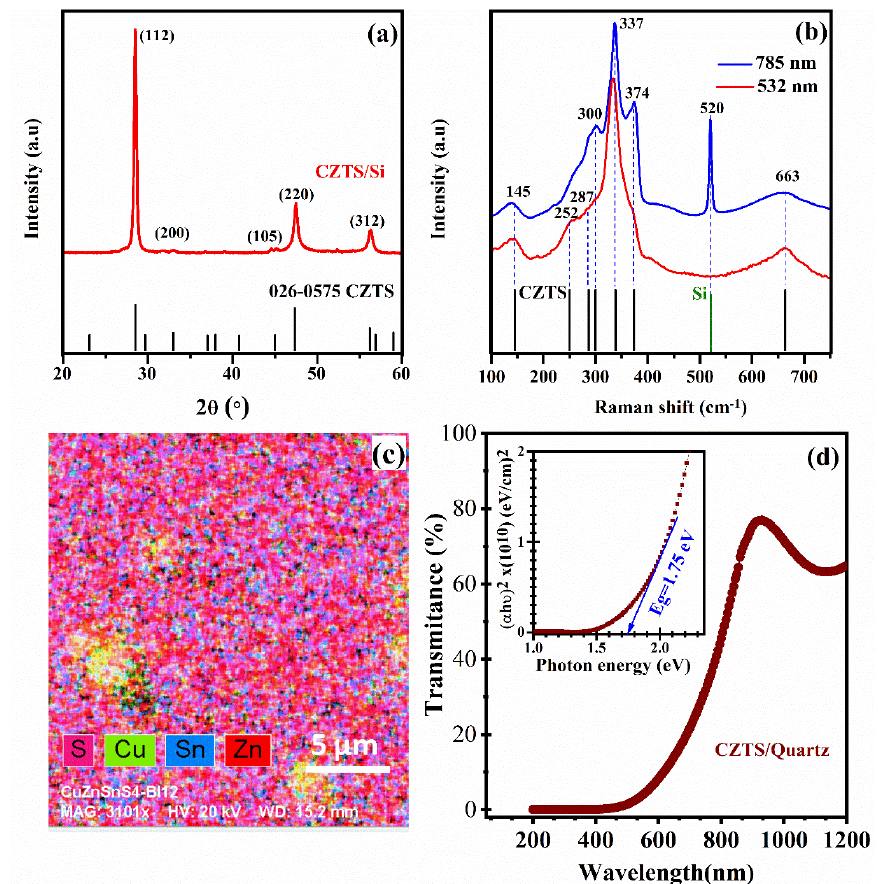
Figure 1. ( a ) Typical XRD pattern of a PLD-CZTS film deposited at N LP = 15000 onto Si (100) substrates (the underlying tick marks indicate the XRD peak positions of the kësterite crystalline structure according to the JCPDS (26-0575) file); ( b ) Raman spectra of the same PLD-CZTS film at two excitation wavelengths (532 and 785 nm); ( c ) EDX mapping of the S, Cu, Sn and Zn elements forming the PLD-CZTS film; ( d ) UV-Vis Transmittance spectrum of the same PLD-CZTS film deposited on the optically transparent quartz substrate (the inset shows the corresponding Tauc plot from which a bandgap of 1.75 eV is deduced).